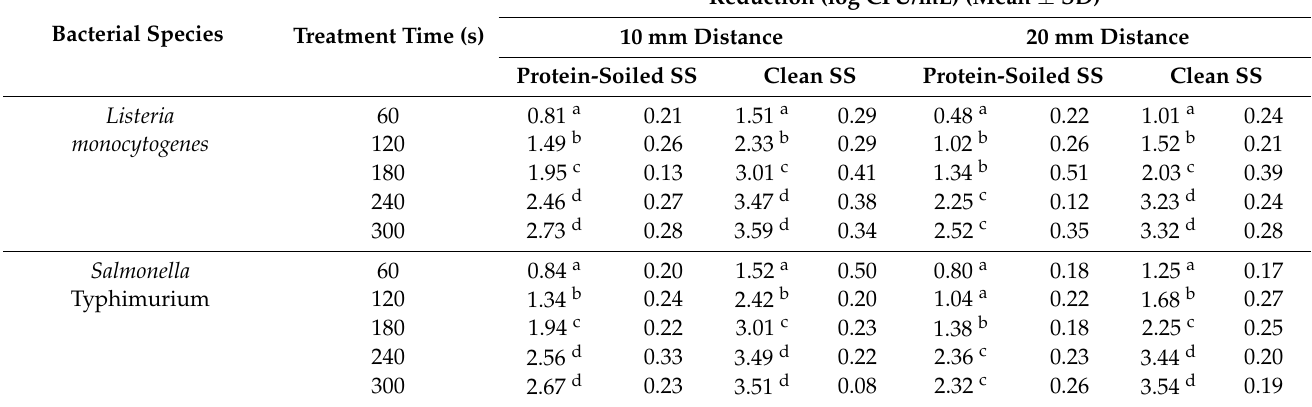
Table 1. Log reduction of L. monocytogenes and Salmonella after CAP treatment from 0 to 300 s, at two different distances (10 and 20 mm), and inoculated on clean stainless-steel (SS) or protein-soiled SS. The results are expressed as the mean ± SD. The superscript letters indicate different subsets for each treatment; the same letter indicates no significant difference when α = 0.05 and n =